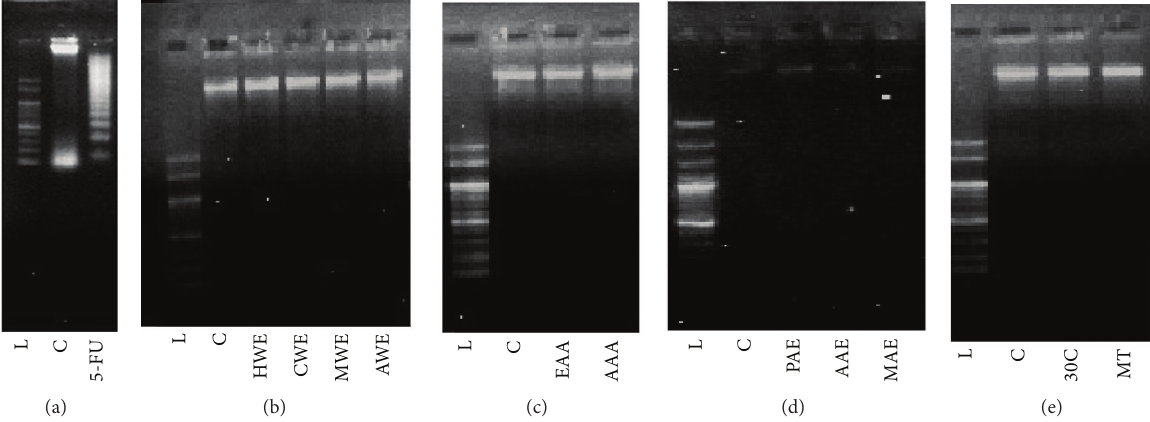
Figure 5: DNA fragmentation analysis in NRK-52 cells, after 48 hours of treatment with IC 50 values of HWE, CWE, MWE, AWE, EAA, AAA, PAE, AAE, MAE, 30 C, and MT of Ruta and 5-FU. (a) L, C, 5-FU, (b) L, C, HWE, CWE, MWE, and AWE, (c) L, C, EAA, and AAA, (d) L, C, PAE, AAE, and MAE (E) L, C, 30 C, and MT. L-Ladder, C-untreated NRK-52E